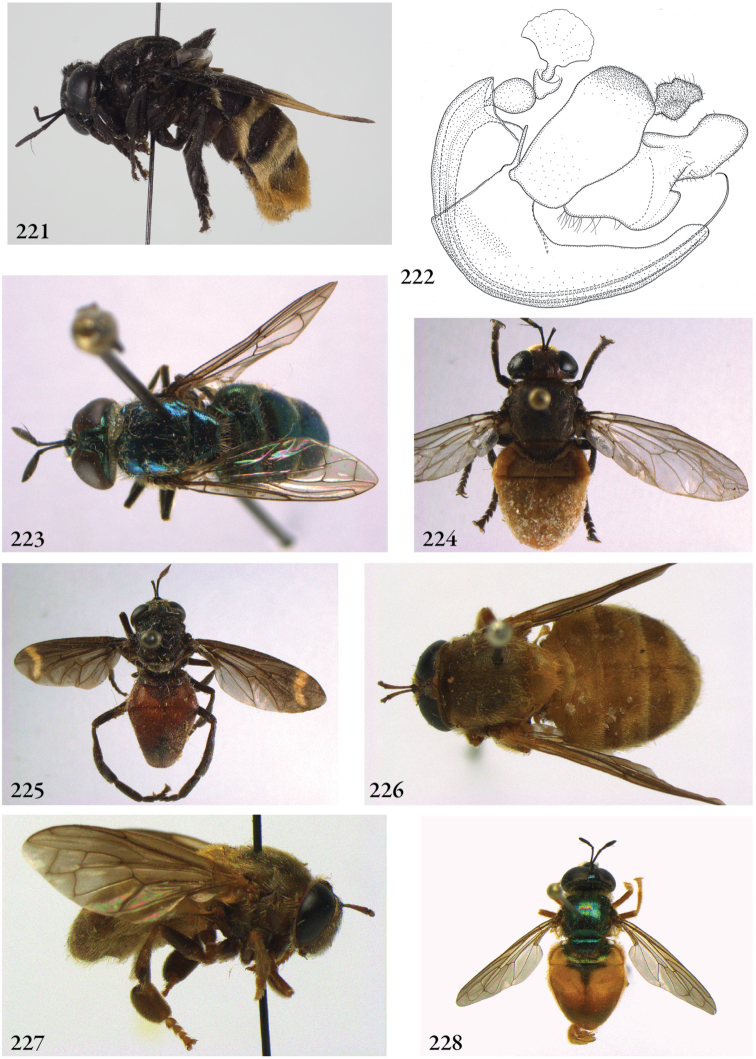
221–222
Microdon (Syrphipogon) fucatissimus male (holotype): 221 habitus lateral 222 genitalia lateral 223–228
Microdon s.l. males, habitus: 223
craigheadi-group: Microdon craigheadi (USA, S-Carolina, coll. BMNH) 224
erythros-group: Microdon luteiventris (Kenya, coll. RMNH) 225
mirabilis-group: Microdon bertonii (Brazil, coll. RMNH) 226
tarsalis-group: Microdon tarsalis (holotype) 227
Microdon tarsalis
228
virgo-group: Microdon rufiventris (Surinam, coll. RMNH).